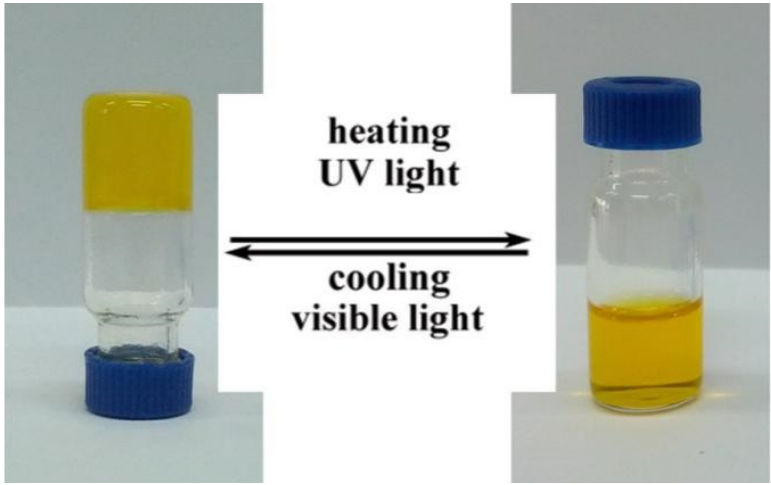
Figure 4. Photographs of the D-Azo-D 230 in water 5.0 wt%: 20 °C ( left ); 80 °C ( right ).